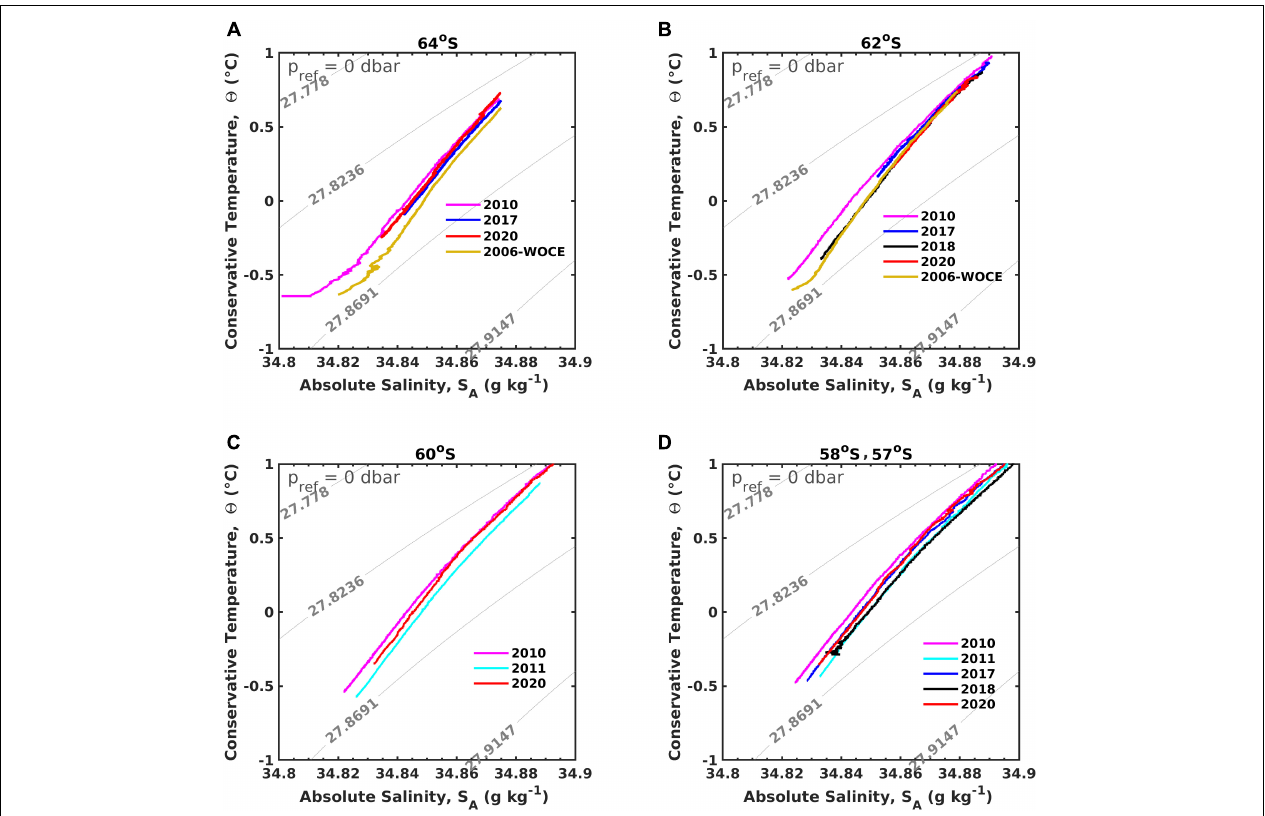
FIGURE 2 | The conservative temperature ( θ )-absolute salinity (S A ) relationship at (A) 64 ◦ S, (B) 62 ◦ S, (C) 60 ◦ S, (D) 58 ◦ S, 57 ◦ S along ∼ 57.5 ◦ E. Refer to Supplementary Table 1 for the exact date and location of CTD